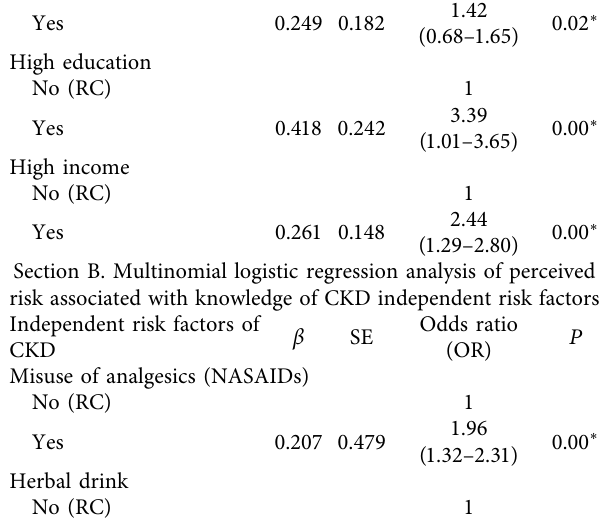
Section C. Multinomial logistic regression analysis of perceived risk associated with knowledge of CKD dependent risk